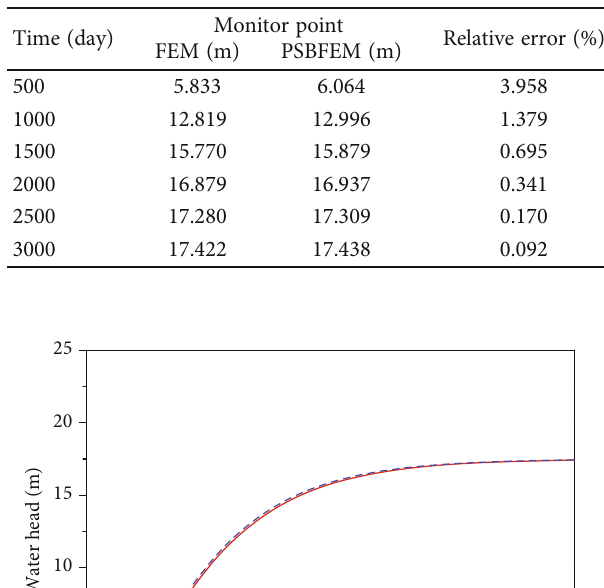
Figure 15: Variation of the water head with time upstream of a concrete dam constructed on anisotropic soil. Table 3: Water head of the monitor points at di ff erent times.